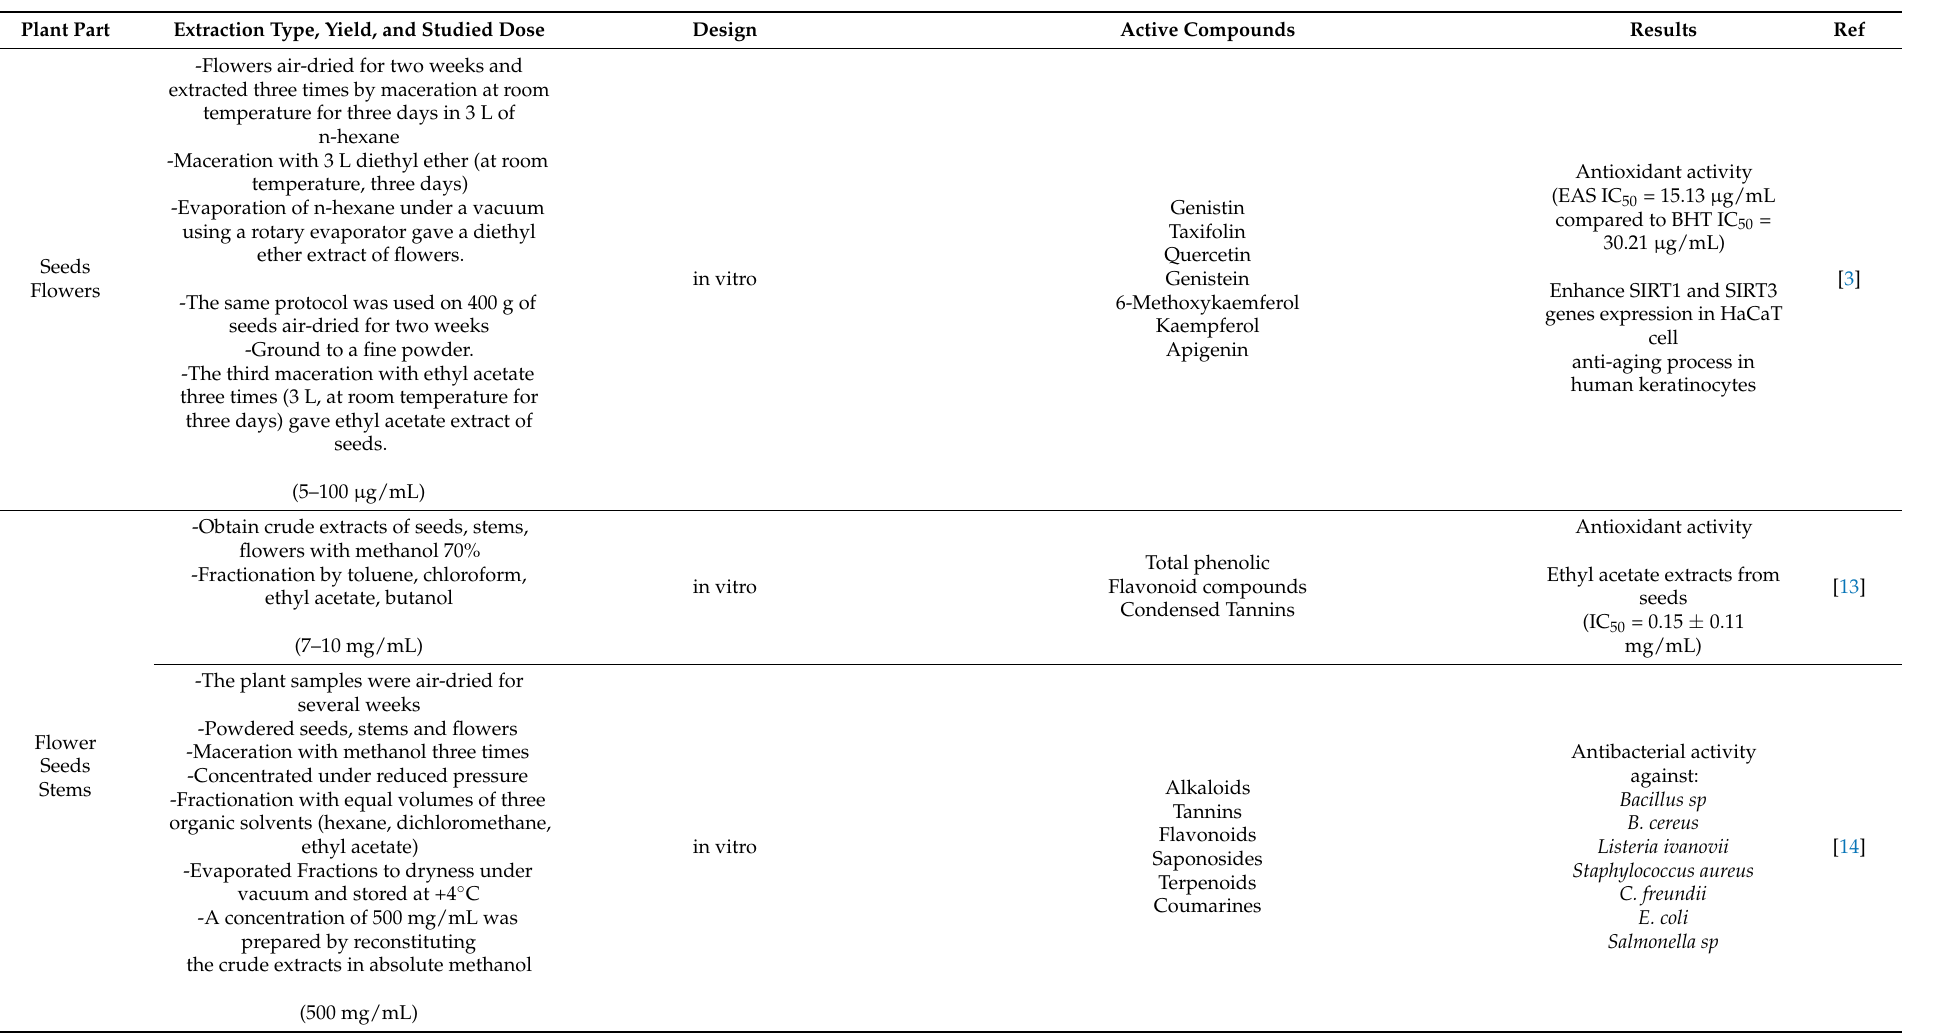
Table 2. Biological properties of R. monosperma